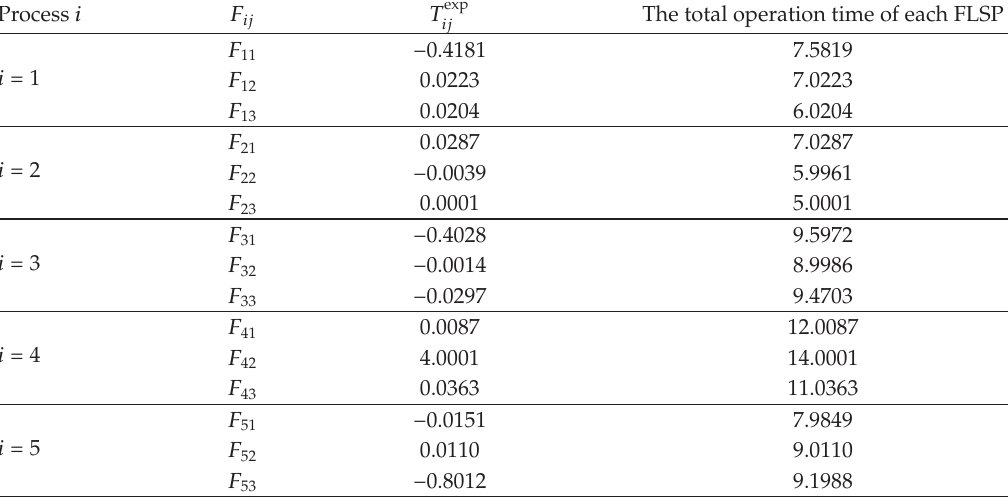
Table 4: Calculation results.